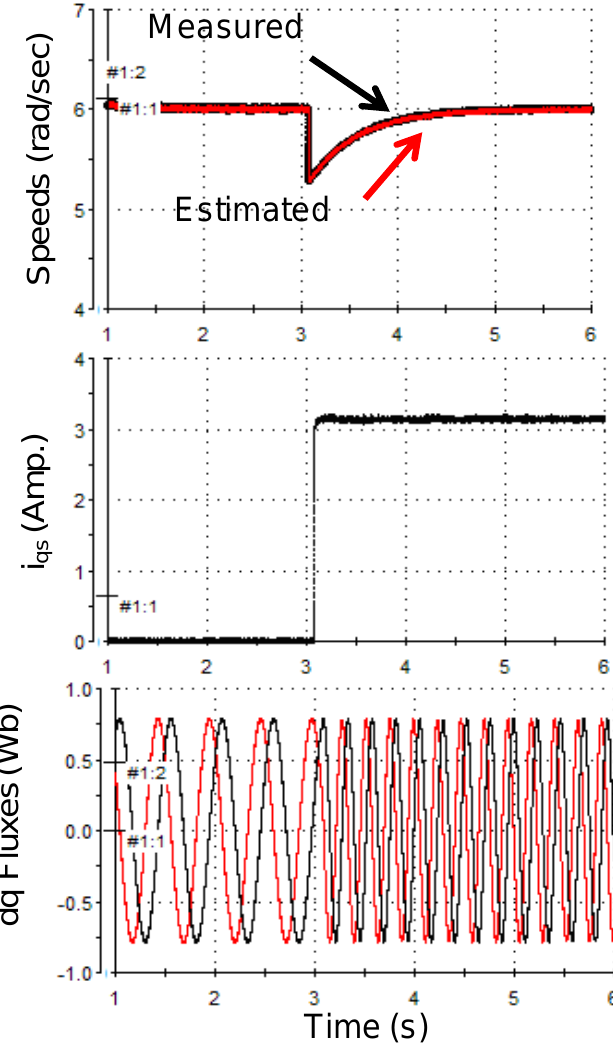
Figure 10. Practical tests at low speeds. Speed reference of 0.04 p.u (6.28 rad/s) with rated T L change of +7 N.m at t = 2 s.